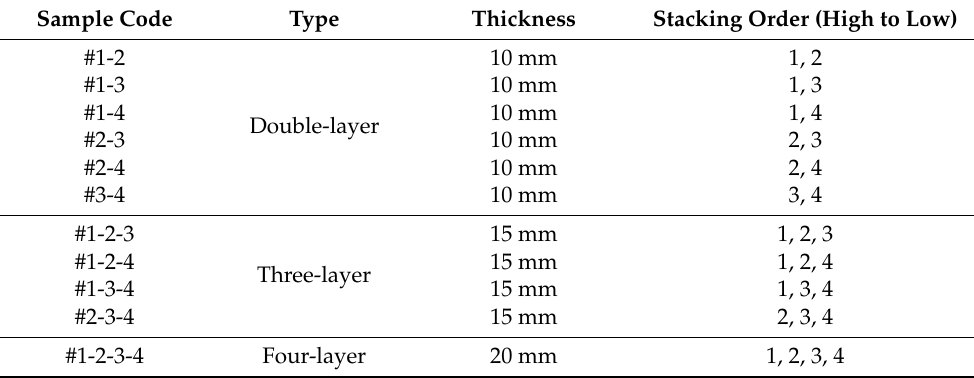
Table 1. Design options for multilayer